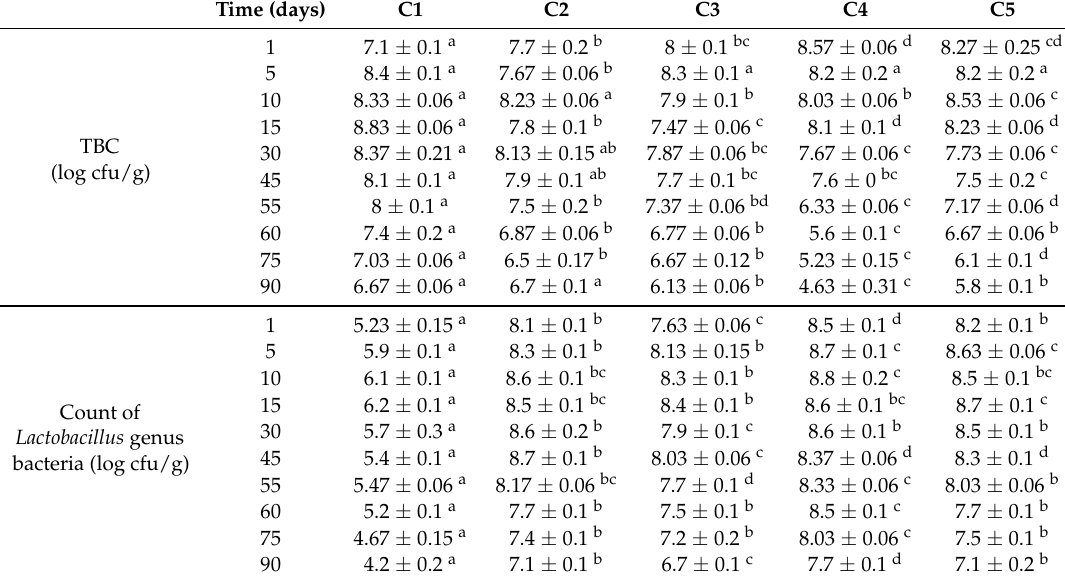
Table 1. Microbial populations (log cfu/g) of total aerobic counts, enterobacteria, yeasts & fungi, lactococci and lactobacilli in Feta-type cheeses during 60 days of ripening and 30 days of storage at 4 ◦